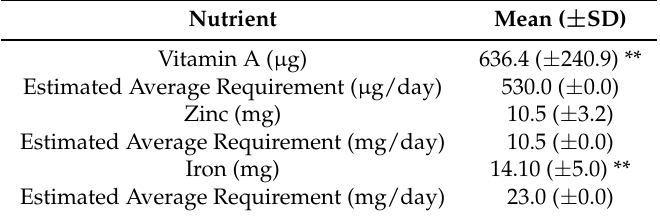
Table 2. Comparison of estimated average requirement (EAR) * and average nutrient intake of participants.